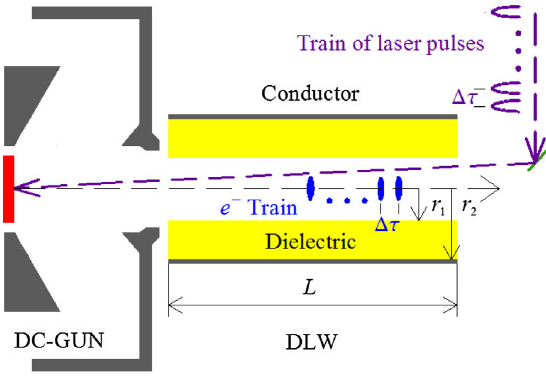
FIG. 1. Cross section draw of the proposed scheme.